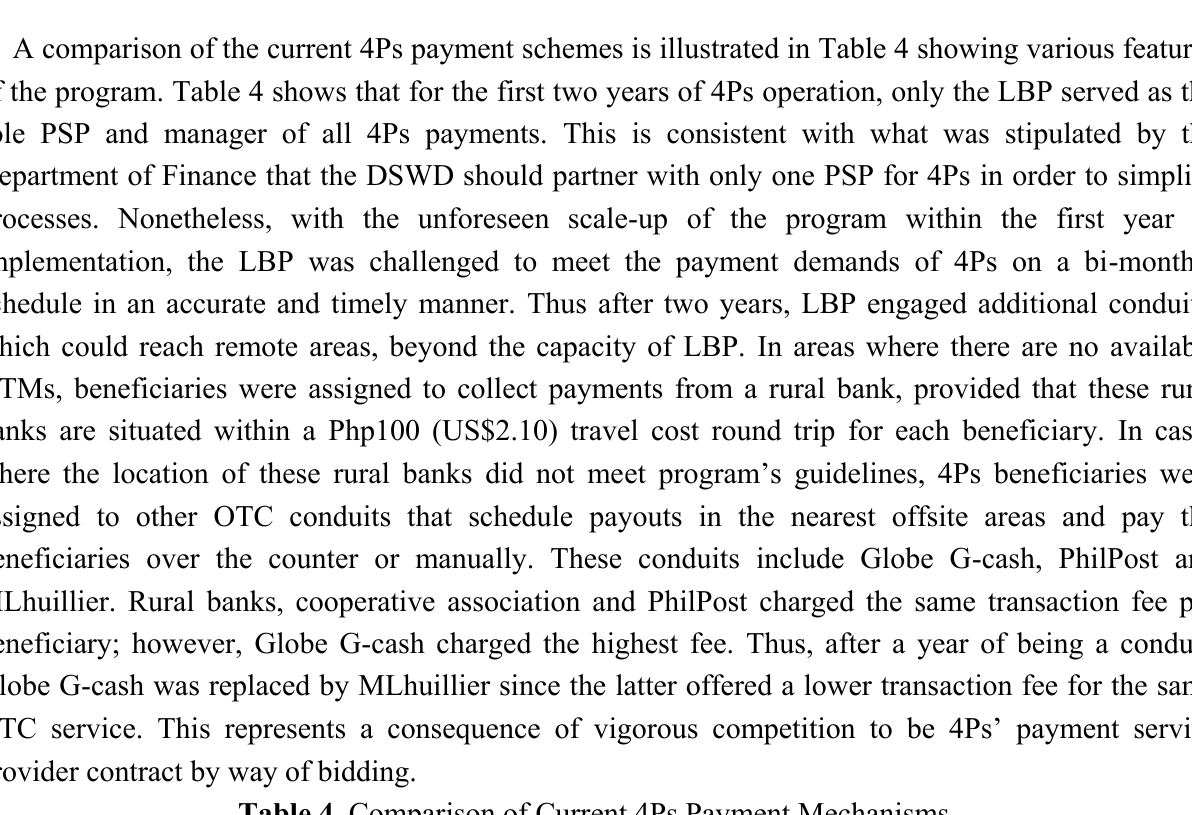
Table 4. Comparison of Current 4Ps Payment